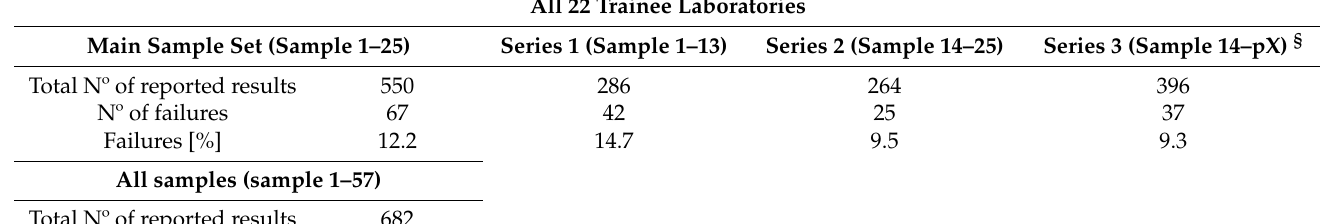
Table 2. Twinning maturation program. The twinning maturation program significantly reduces the number of wrong MRD assessments after a first series of training samples.